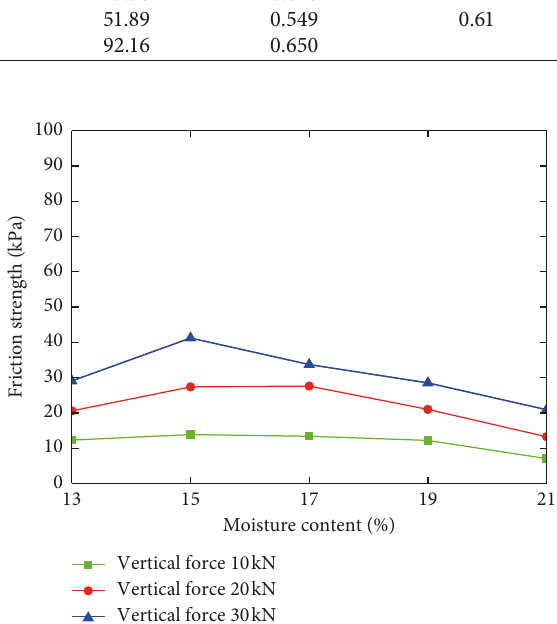
Figure 5: Friction strength of concrete and soil for different moisture contents.